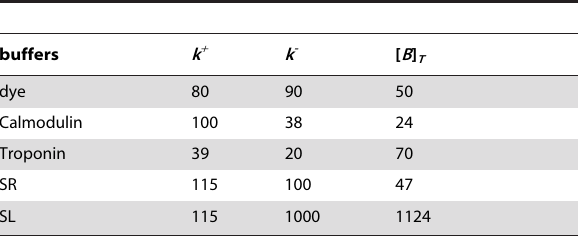
Table 2. Standard parameter values for dye and endogenous